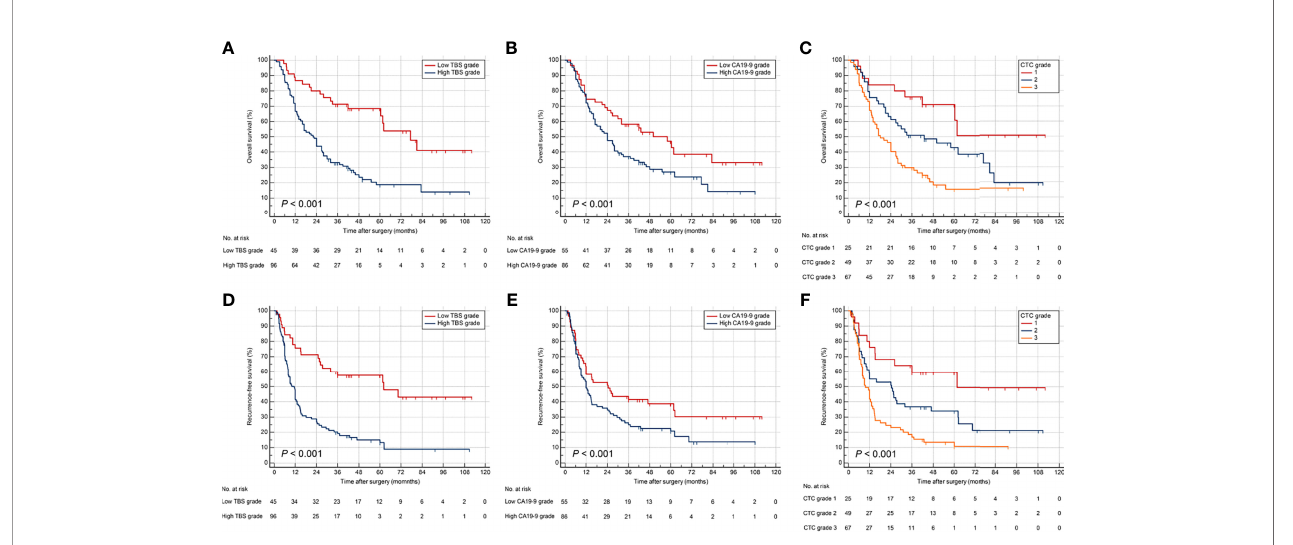
FIGURE 4 | Kaplan – Meier curves for OS and RFS strati fi ed by TBS (A, D) , CA19-9 (B, E) , and CTC grade (C, F) in the validation